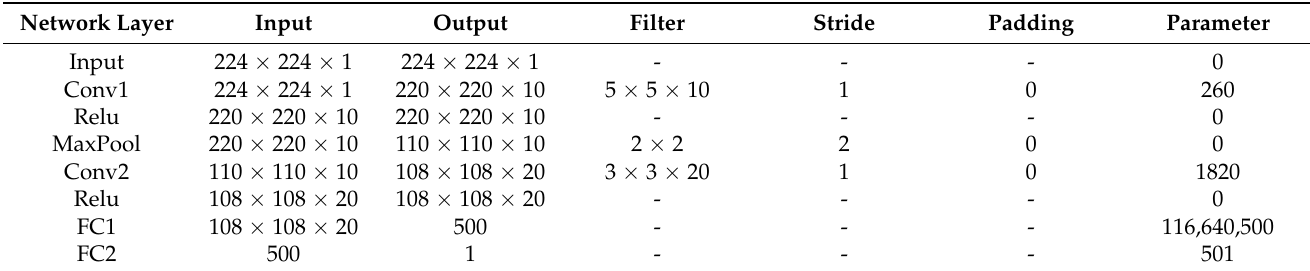
Table 2. Setting of the parameters of convolutional neural network (CNN) in the model structure diagram.